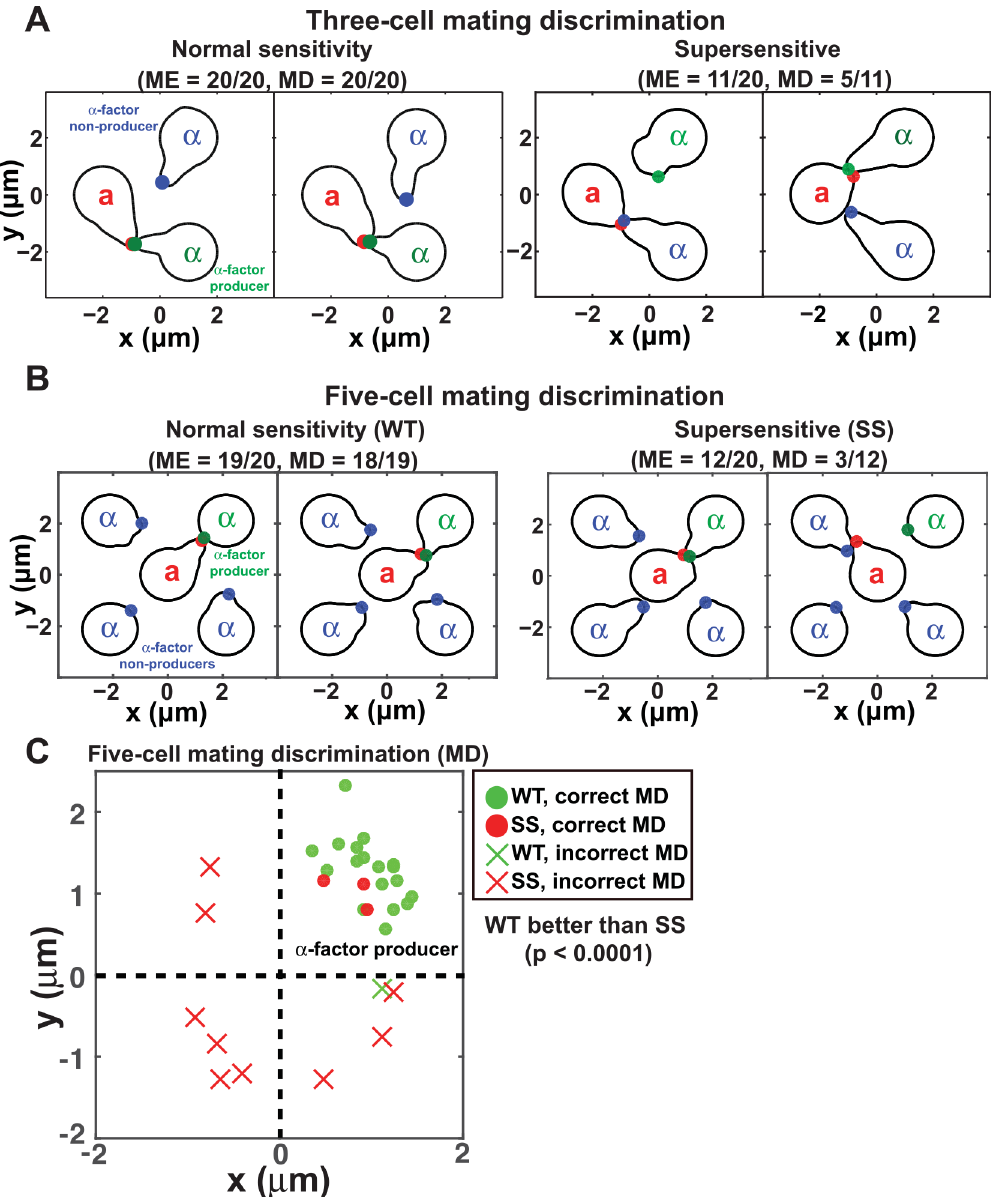
Fig 7. Modeling mating discrimination. (A) Three-cell mating discrimination simulations. One a -cell and two α - cells were arranged so that the a -cell was equidistant from the α -cells. One α -cell makes α -factor ( α -factor producer, green) and the other α -cell does not ( α -factor non-producer, blue). 20 simulations were run to determine the ratio at which the a -cell would mate with the α -factor producer versus the non-producer. Two sample simulations are presented. The left panel shows an a -cell with wild-type sensitivity, and the right panel shows a supersensitive a - cell. ME indicates mating efficiency; MD indicates mating discrimination. (B) Five-cell mating discrimination simulations. Four α -cells are arranged in a square with one bar1 Δ a -cell in the center. One α -cell makes α -factor ( α - factor producer, green) and the other three cells α -cell do not ( α -factor non-producers, blue). 20 simulations were run to determine mating discrimination, and two sample simulations are presented. The left panel shows an a -cell with wild-type sensitivity, and the right panel shows a supersensitive a -cell. (C) Mating location plots for a -cells possessing normal sensitivity (WT, green) or supersensitivity (SS, red) in five-cell mating discrimination simulations. Each dot (correct MD) or cross (incorrect MD) symbol represents the polarisome location of the a -cell at the time of mating. The α -cell producing α -factor was in the top-right quadrant. The cells possessing normal sensitivity showed significantly better mating discrimination (MD) than the supersensitive cells (p < 0.0001, Fisher ’ s Exact